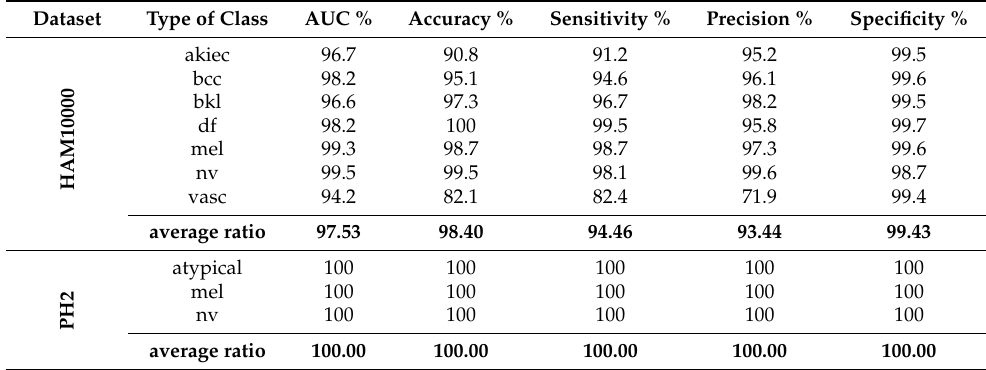
Table 8. Performance of ANN with fused features of MobileNet and handcrafted for dermoscopic image analysis to classify HAM10000 and PH2 dataset skin lesions.